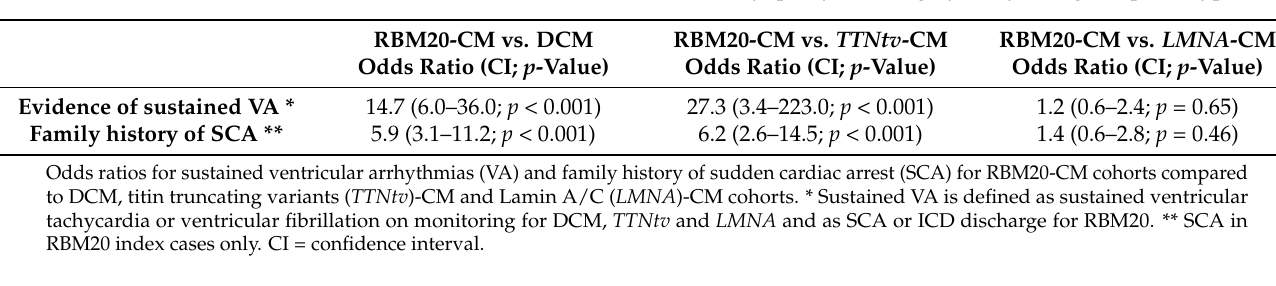
Table 3. Modified from Parikh et al., 2019 [12]. RBM20 -related cardiomyopathy has a highly arrhythmogenic